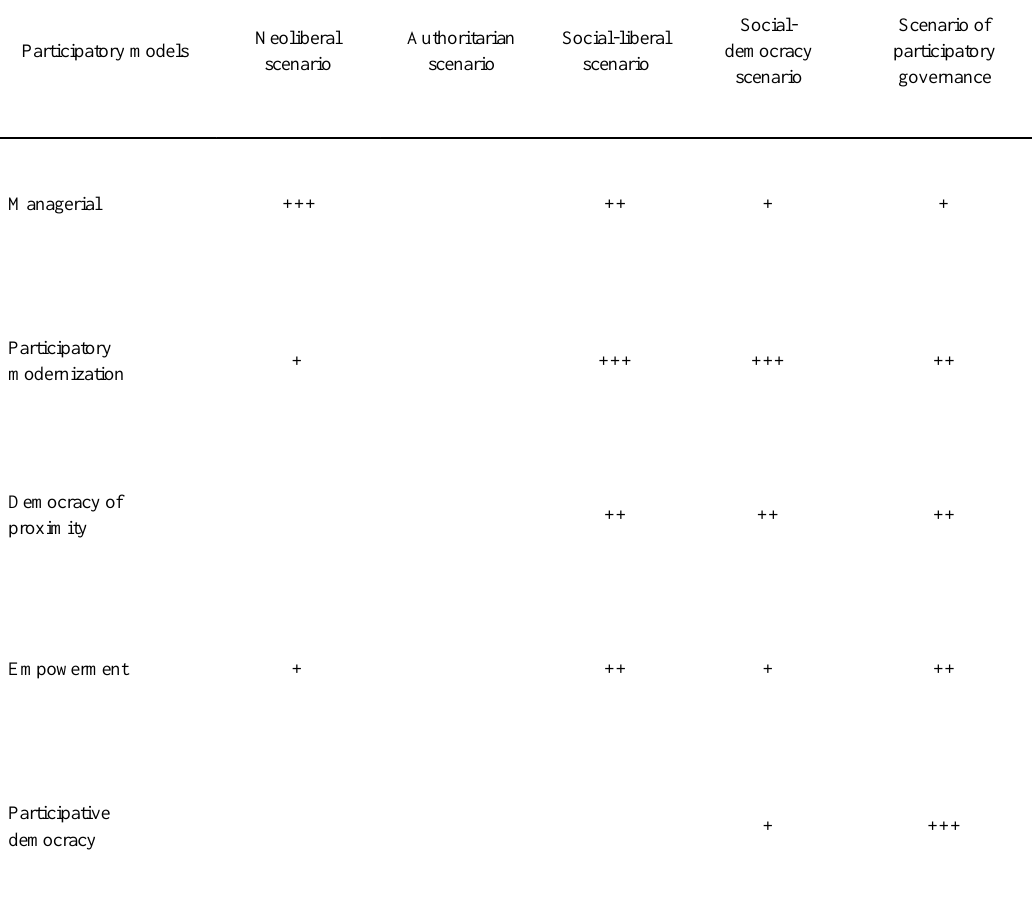
Table 2: The use of participatory models in five policy scenarios (Bacqué et al.,